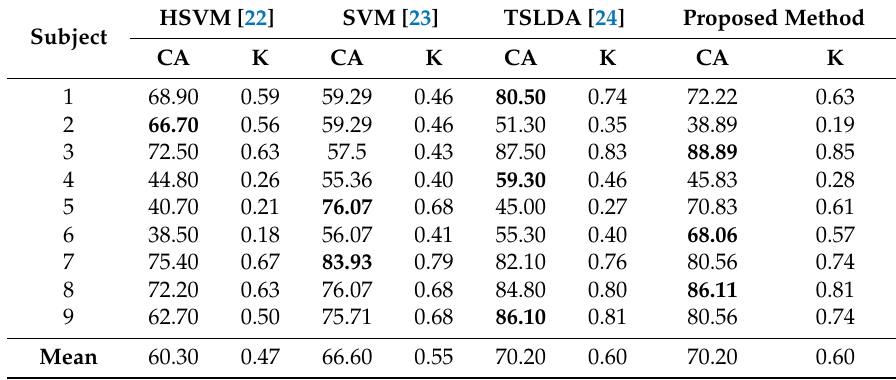
HSVM, SVM, TSLDA, and our proposed method, for data set 2a from the 2008 BCI